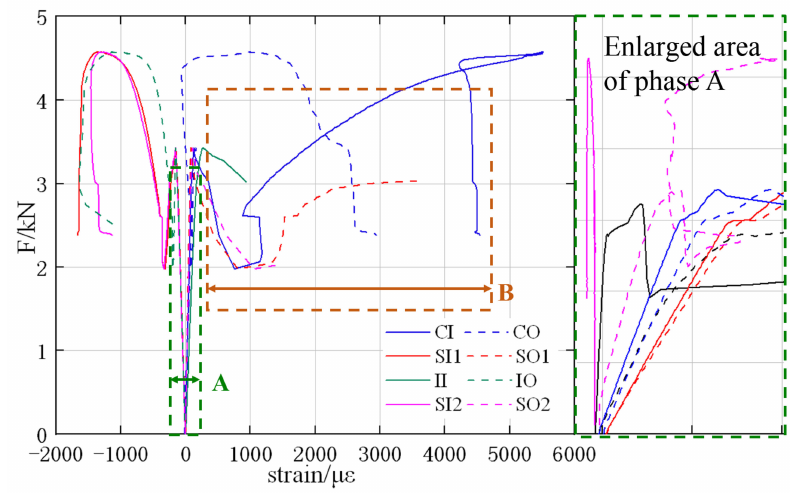
Figure 12. Comparison between the CI and the CR